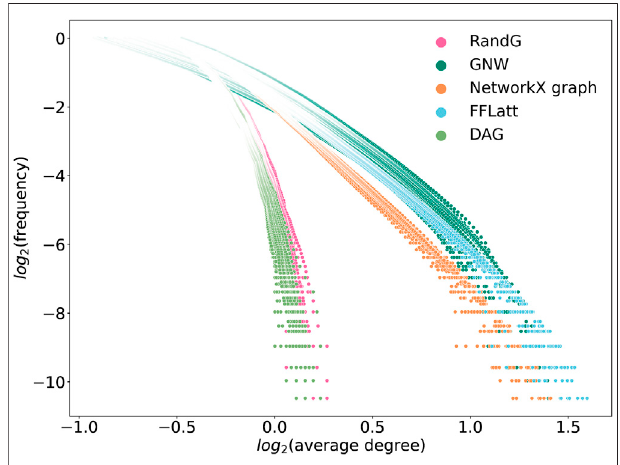
FIGURE 8 | Degree distributions in simulated networks generated by differentalgorithms.GRNsofsizes500,750,1,000,and1,500wereused,ten of each size. A power-law distribution should generate a straight